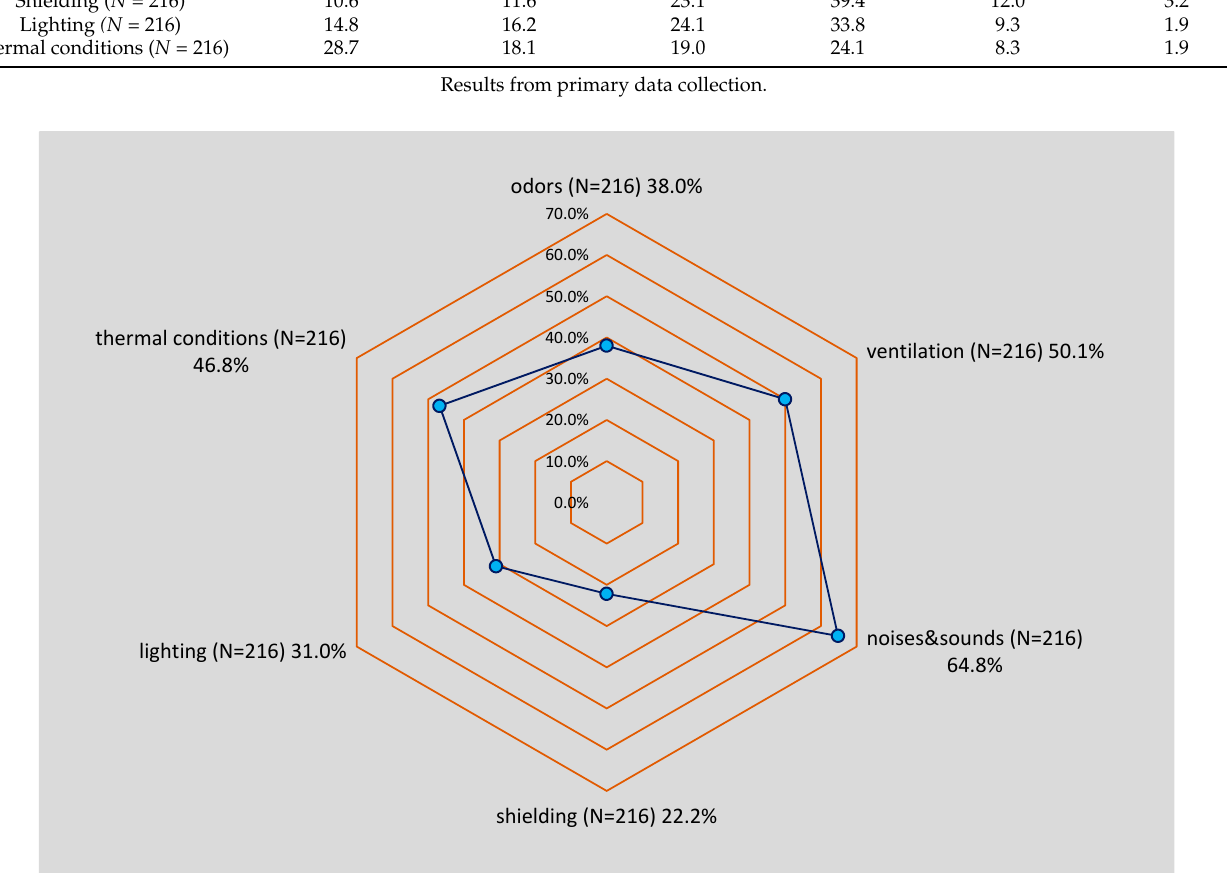
Table 1. Occupants’ satisfaction with the adjustability of IEQ parameters in their work environment.